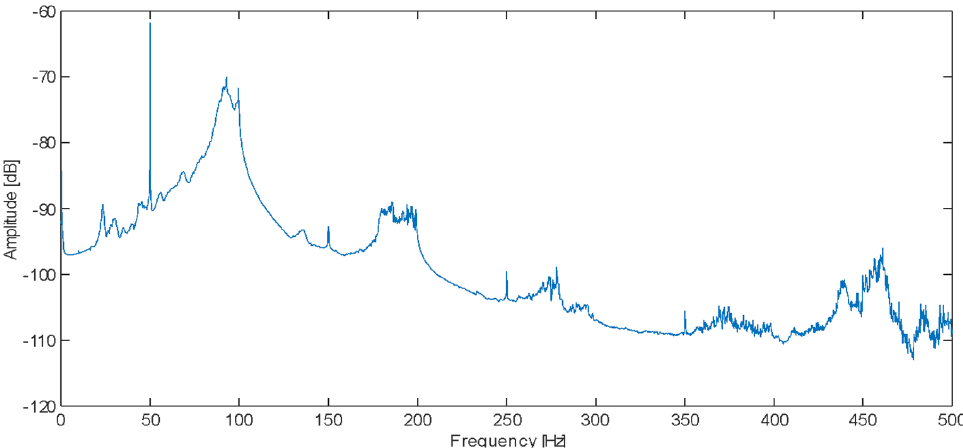
Figure 9. SUM indicator from CPD functions acquired during run-down.